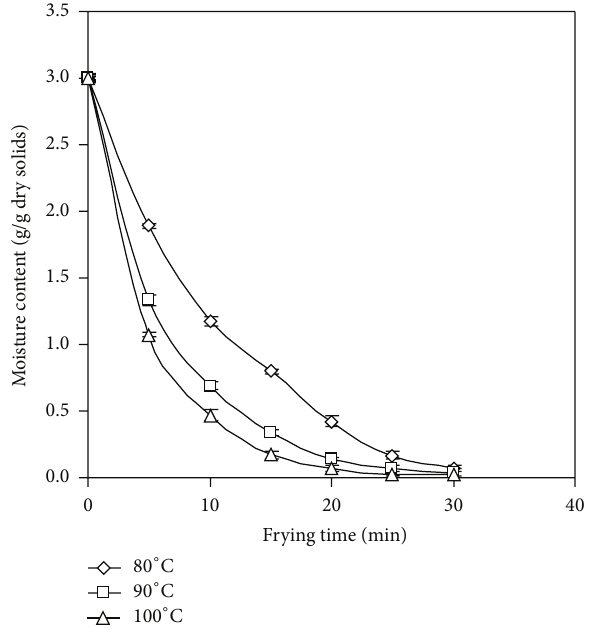
Figure 2: Moisture loss in jackfruit chips during frying.